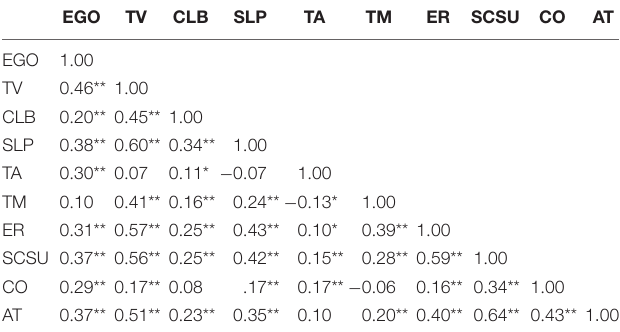
TABLE 3 | Correlation matrix of the SRL factors.